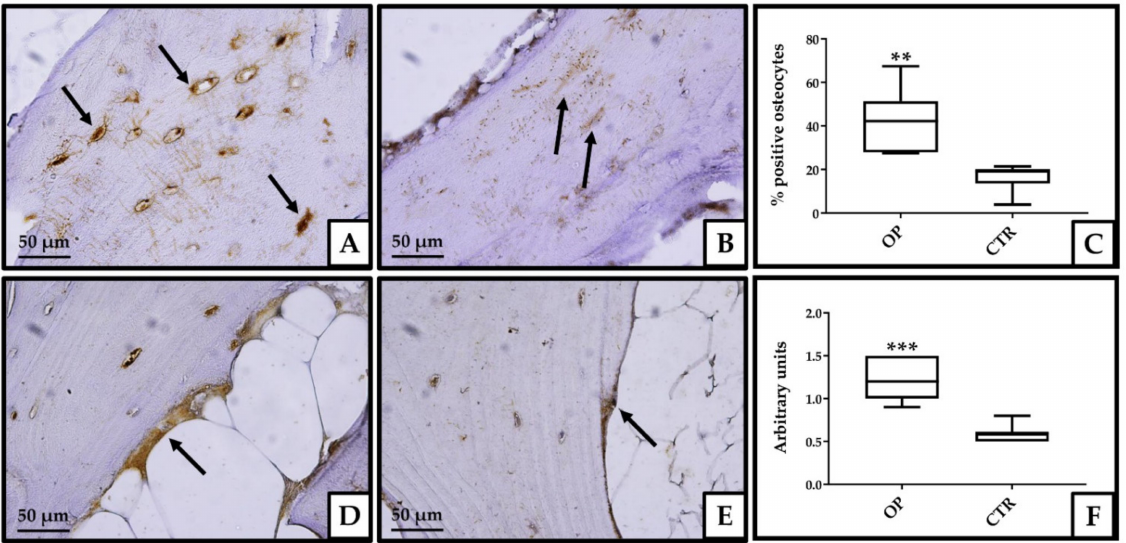
Figure 2. Immunohistochemical analysis of CLU protein expression in bone head biopsies. Image shows the strongly positive signal in osteocytes from the bone tissue of OP patients ( A ), whereas in the bone tissue from CTR subjects, the osteocytes were characterized by lower levels of CLU expression ( B ). The percentage of positive osteocytes was significantly higher in the experimental group of OP patients than in the CTR group (** p < 0.01) ( C ). Bone tissue osteoblasts from OP patients showed strong positivity to CLU signal ( D ), compared with the same bone tissue cells from CTR subjects, which were characterized by weak expression of the protein ( E ). The difference in expression intensity was evaluated semi-quantitatively and was statistically significant between OP and CTR groups (*** p < 0.001) ( F ). Black arrows indicate osteocytes ( A , B ) and osteoblasts ( D , E ), respectively. Images at 20 × magnification, scale bar 50 µ